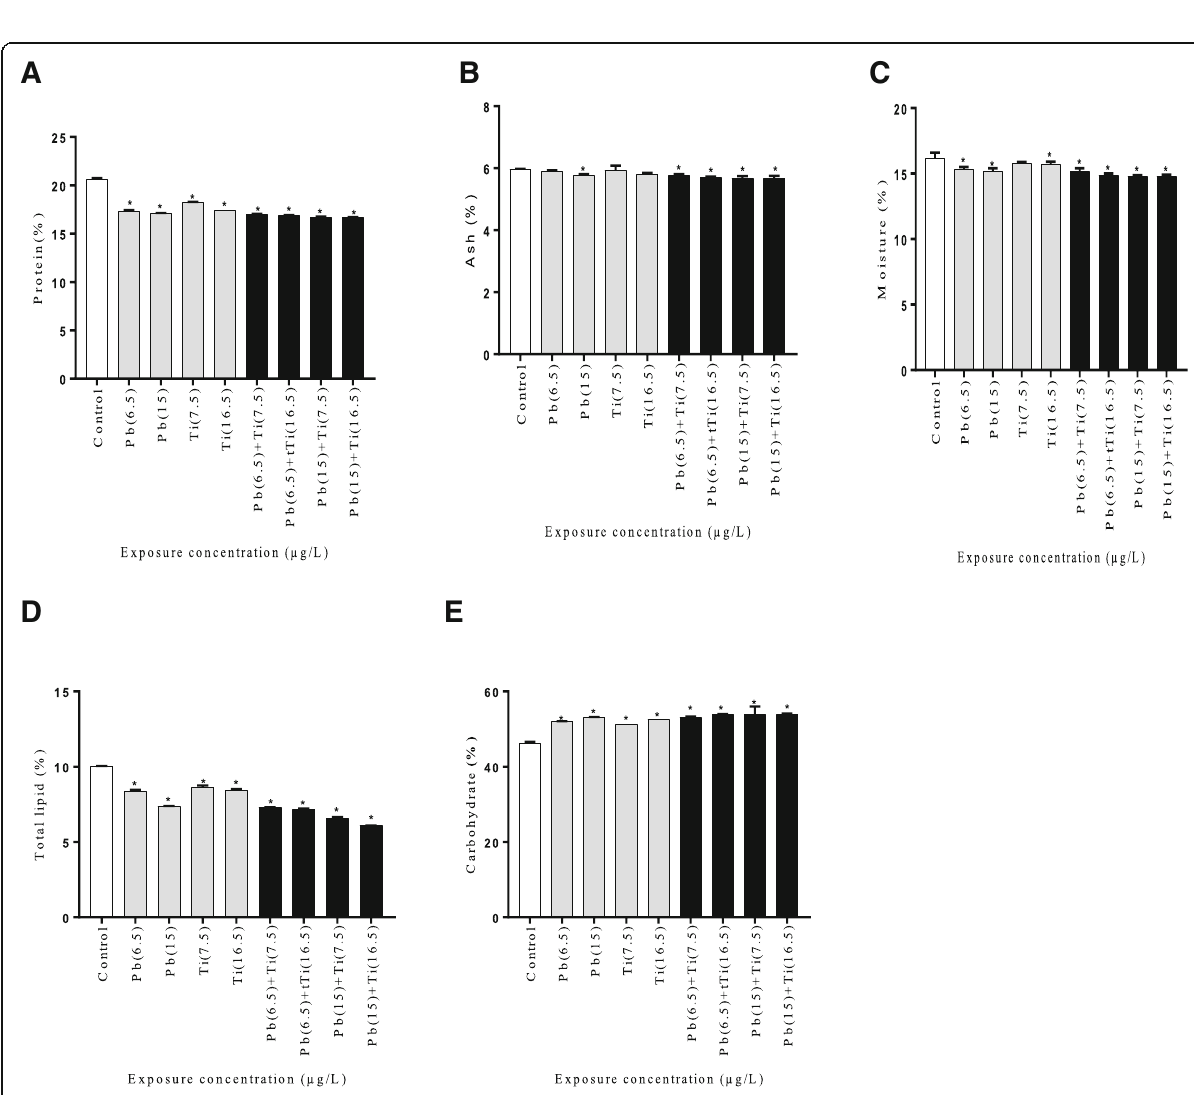
Table 3 Quantified DNA of C . gariepinus fed contaminated copepods